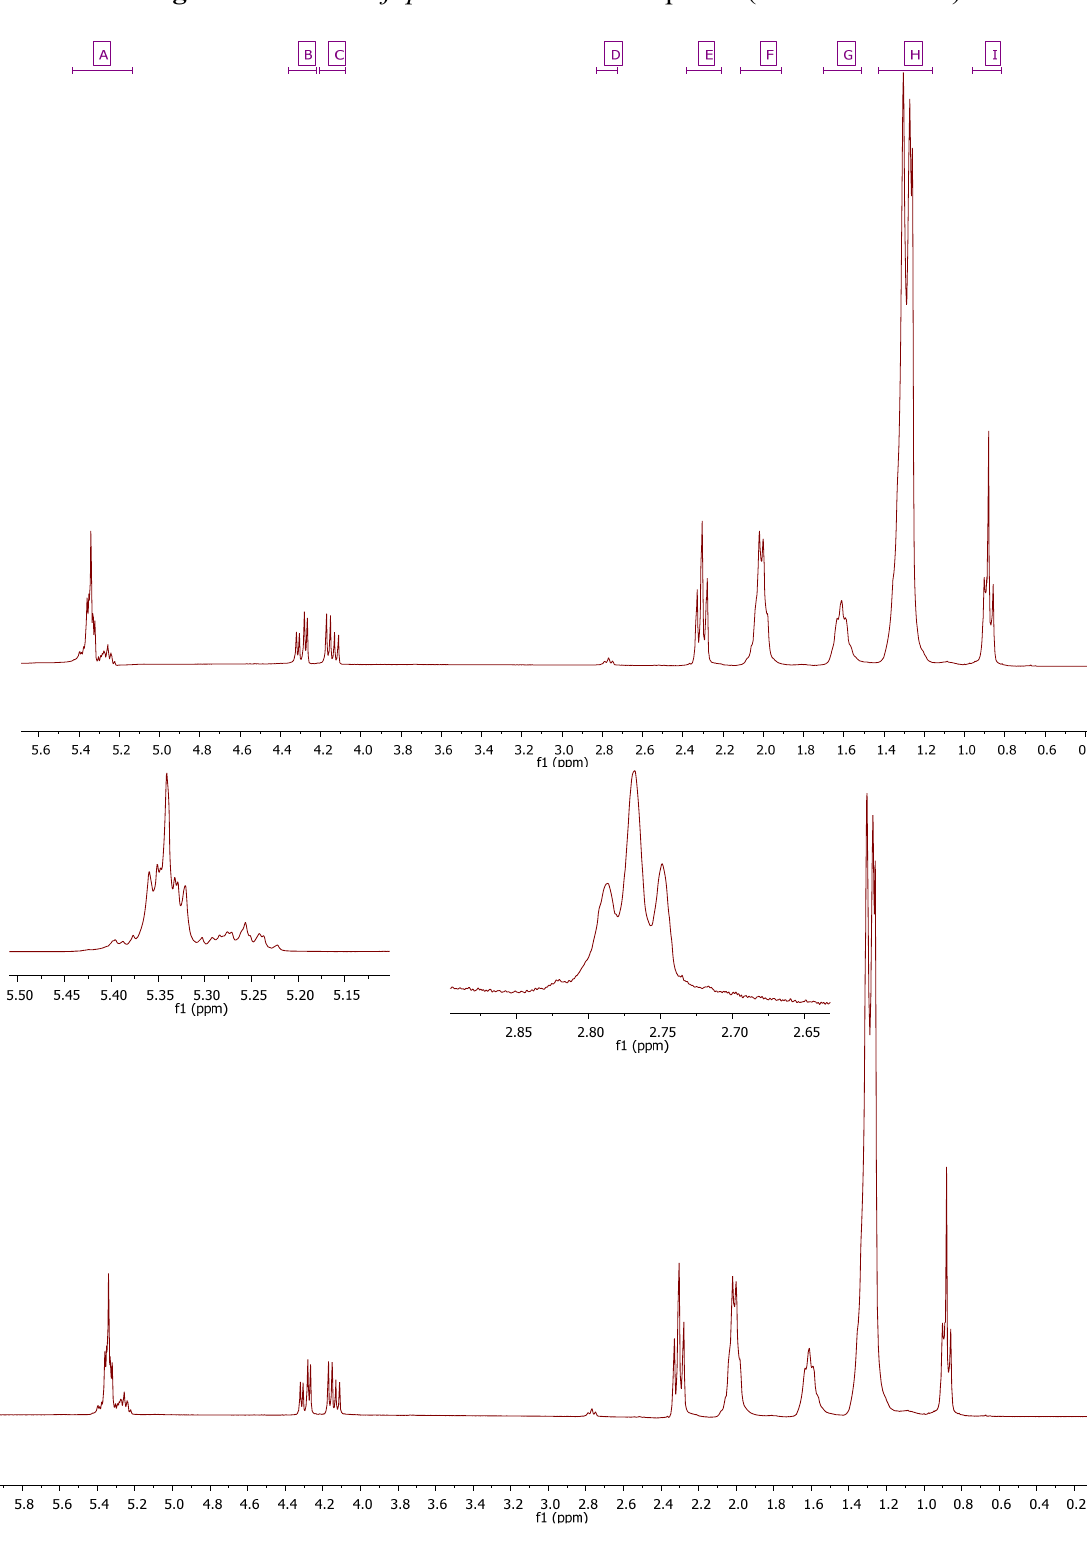
Figure 2. Camellia japonica oil 1 H-NMR spectra (300 MHz for 1